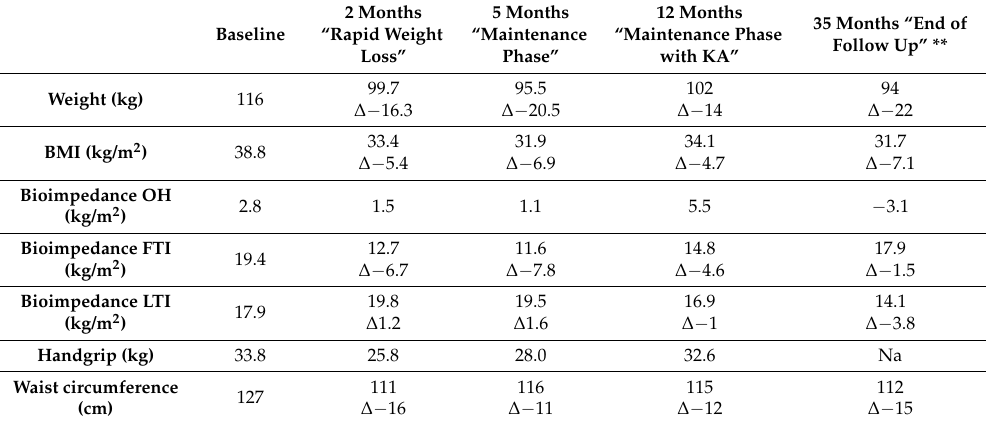
Table 4. Anthropometric data at baseline, 2 months, 5 months, 12 months and end of follow-up.